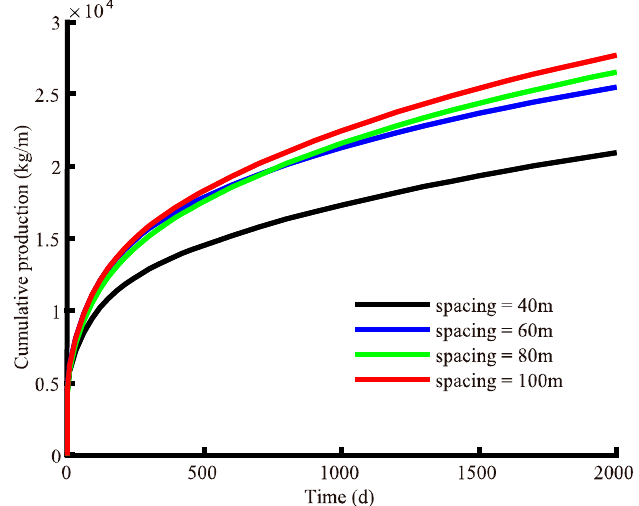
Figure 19. Comparison of cumulative production curves with different well-spacing.